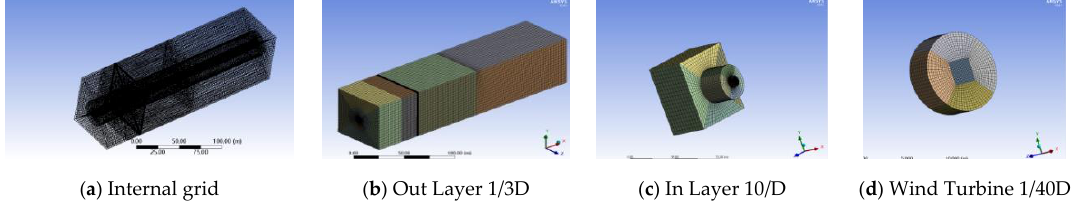
Figure 5. Mesh design scheme.